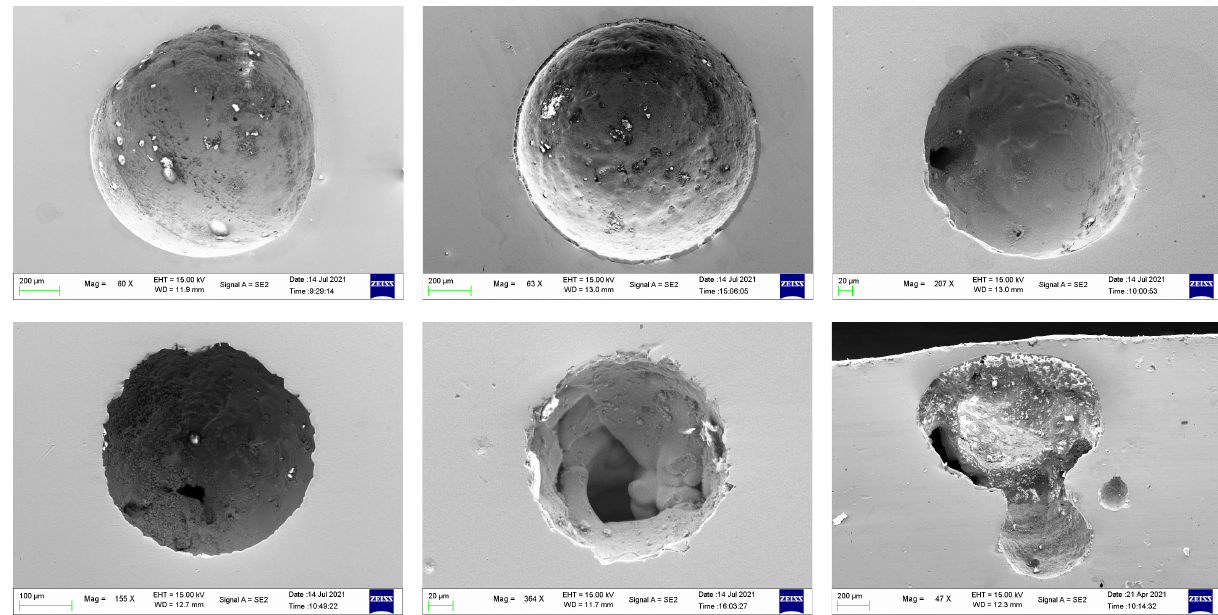
Figure 6. SEM images of bubbles captured in liquid steel of the tundish.